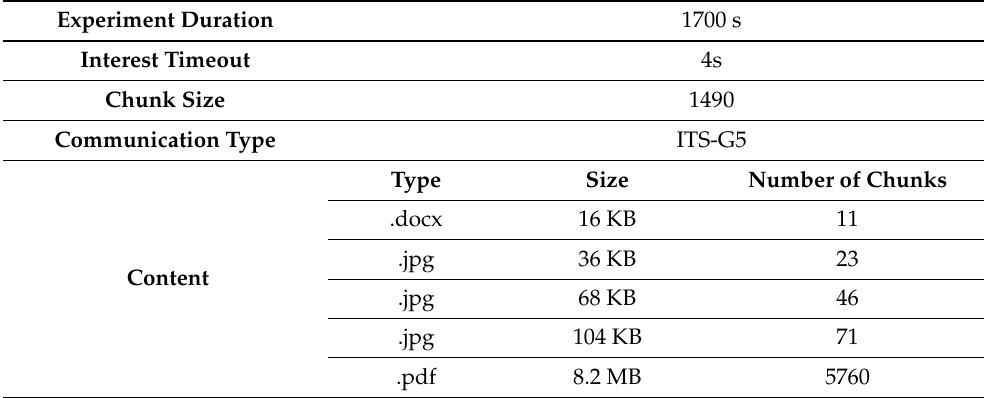
Table 1. City scenario